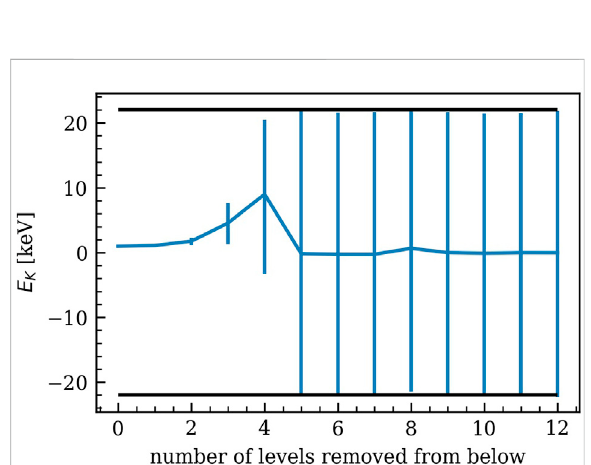
FIGURE 7 The distribution of E K for 169 Er at N 4 LO and k max =10 as we successively remove the lowest energy levels from the data set D . Thesolidbluelineconnectsthemedianvaluesandtheerrorbands encompass uncertainties between on the 16th and 84th percentiles of the samples in the marginalized distribution. The solid black lines show to size of the standard deviation set with the Gaussian prior on E K